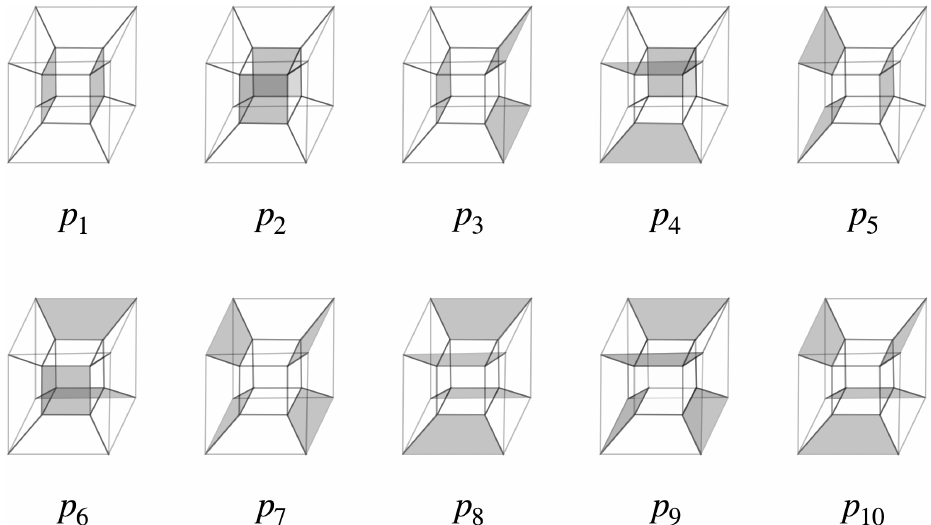
Figure 20 . The ten perfect matchings for the cube model. For clarity, we have only colored the chiral faces in